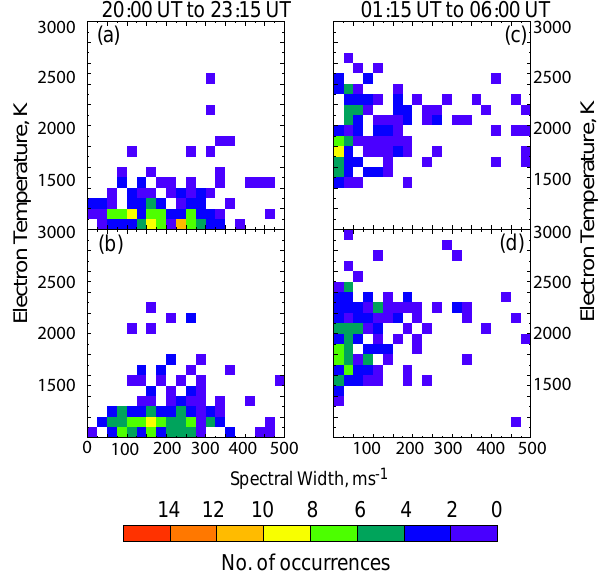
Fig. 8. Electron temperature from the EISCAT mainland beams vs. spectral width from the CUTLASS Finland radar, the data is restricted to 71 ◦ to 72 ◦ latitude AACGM. Left column, data from 20:00UT to 00:15UT, right column, data from 00:15UT to 06:00UT. Top row, EISCAT beam 1, bottom row, EISCAT beam 2.